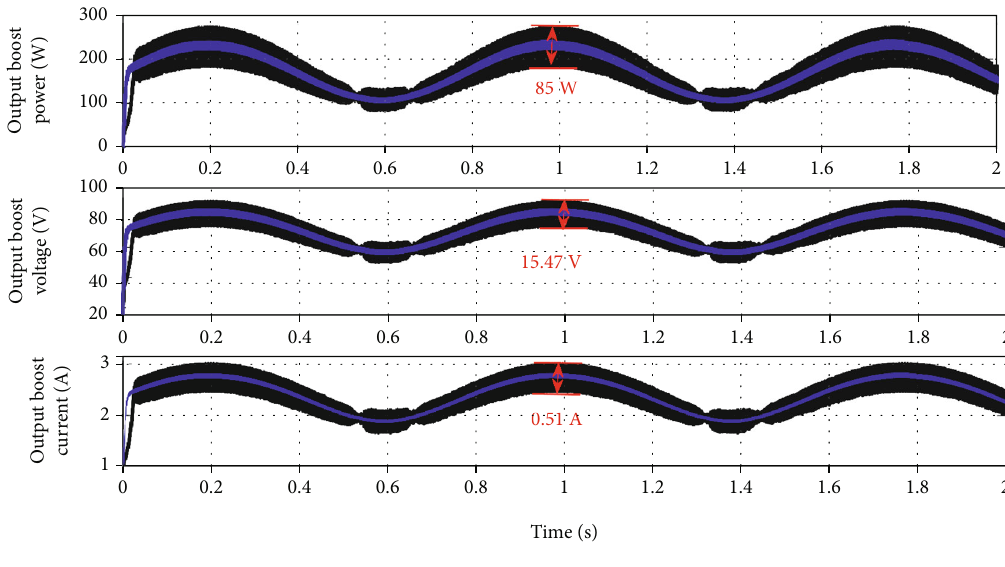
Figure 20: Output power current and voltage of the boost converter. Table 3: Summary of the simulation results comparison of INC and the proposed MPPT schemes under the Sin scenario. Sin test